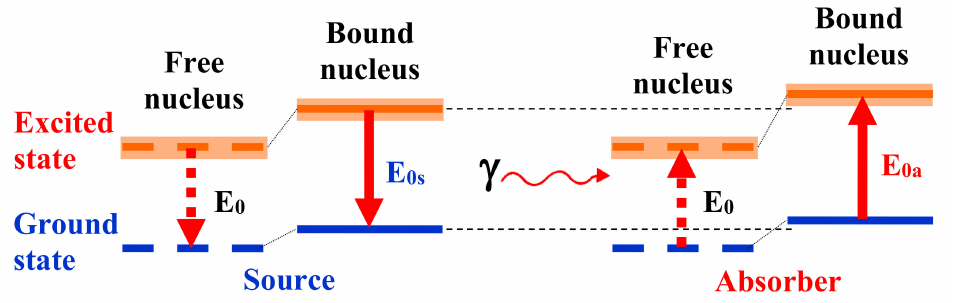
Figure A2. Diagram of the energy levels and nuclear transitions for the source and absorber. The case of bound nuclei.